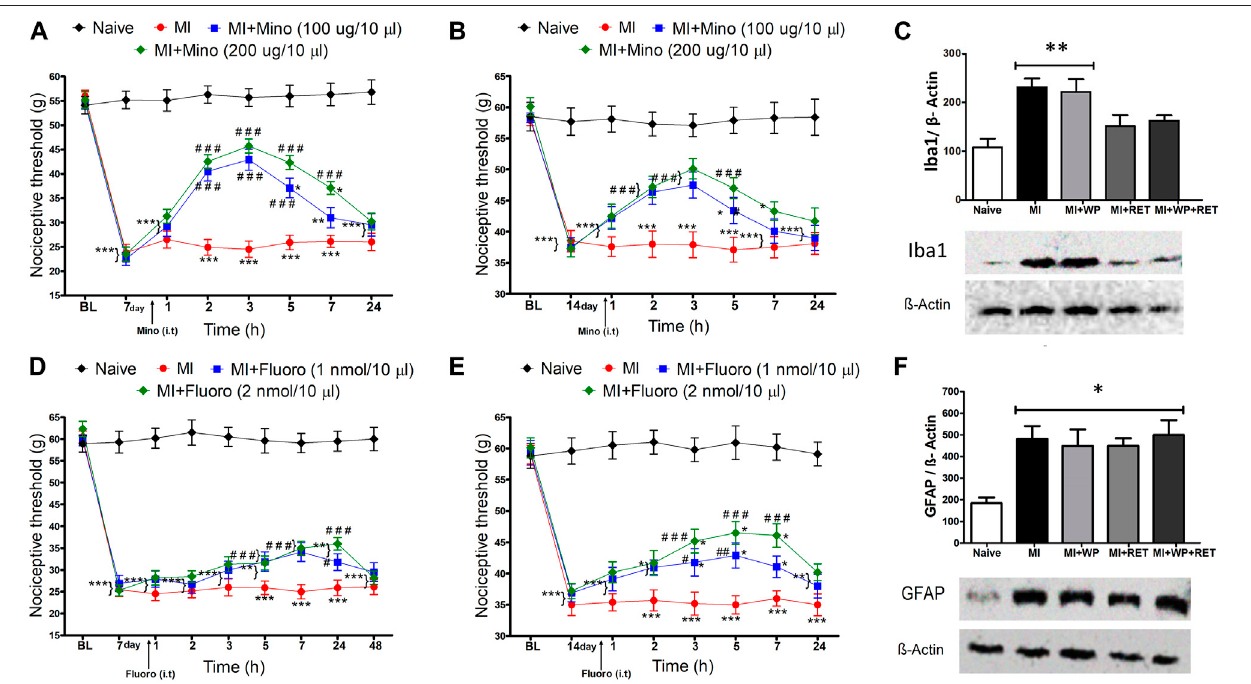
FIGURE 7 | Spinal involvement of the glial cells in the muscle injury – induced nociception. On the 7th or 14th day after the injury, minocycline [Mino, (A,B) ] or fl uorocitrate [Fluoro, (D,E) ] was intrathecally administered, and new measurements of the nociceptive threshold were performed after 1, 2, 3, 5, 7, 24, or 48 h. After the 2nd week of theresistance exercise training (RET) and/or whey protein (WP) supplementation, the Iba1 (C) and GFAP (F) protein-level expression in thespinal cord was analyzed in rats with and without muscle injury (MI). Data are expressed as the mean ± S.E.M. of 4 – 6 animals per group. * p < 0.05, ** p < 0.001, and *** p < 0.001 indicatestatisticalsigni fi cancecomparedtothenaïvegroup;*** p < 0.05, ## p < 0.01,and ### p < 0.001indicatestatisticalsigni fi cancecomparedtotheMIgroup.One(for Western blot assay) and two-way (for pharmacological assays) ANOVA followed by the Bonferroni post hoc test.